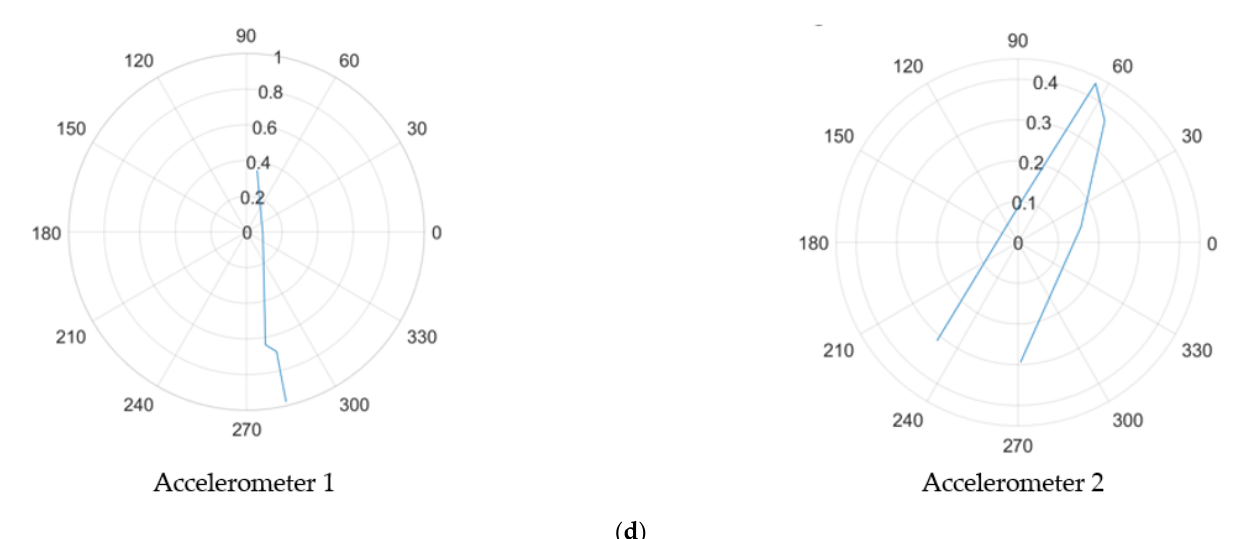
Figure 11. Hodogram analysis for the micro- and macrocrack of the SFRSCC beam: ( a ) amplitude – time curves highlighting the analysed sections; ( b ) hodograms for the microcrack, ( c ) hodograms for Stage 1 macrocrack, and ( d ) hodograms for Stage 2 macrocrack.